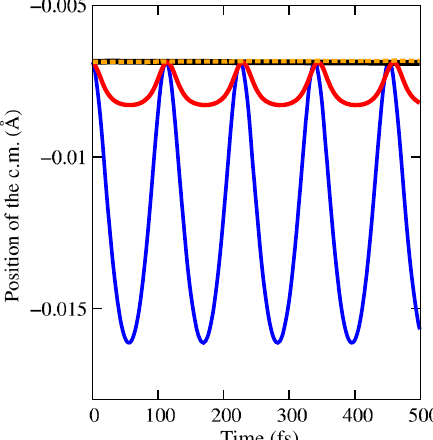
FIG. 5. Distance of the oxygens and position of the proton during the final steps of the dynamics: BO approximation with 16 a : m : u : (blue lines), BO approximation adding M M O þ ¼ O − ¼ 1 a.m.u. to the mass of M the proton mass M (red lines), H ¼ O − the BO approximation corrected by the position-dependent dressed mass (orange lines), and Ehrenfest dynamics (black lines). When position-dependent mass corrections are included in the BO approximation, the dynamics approaches reference FIG. 6. Position of the c.m. as a function of time. The color code results (Ehrenfest) that explicitly take into account nonadiabatic is the same as that used in Fig. 5. Here, we show how the position effects. As expected, the mass corrections yield a slower of the center of mass is fixed when the position-dependent mass evolution than BO dynamics with bare oxygen masses. corrections are included in the BO